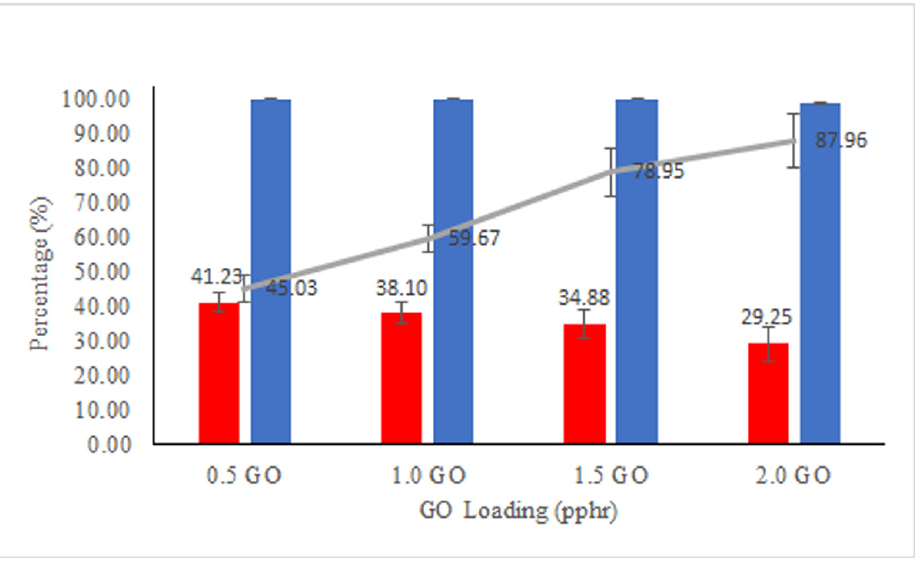
Figure 9. FRR (normal rinsing) , FRR (back flushing) , and Rt values of the membranes.